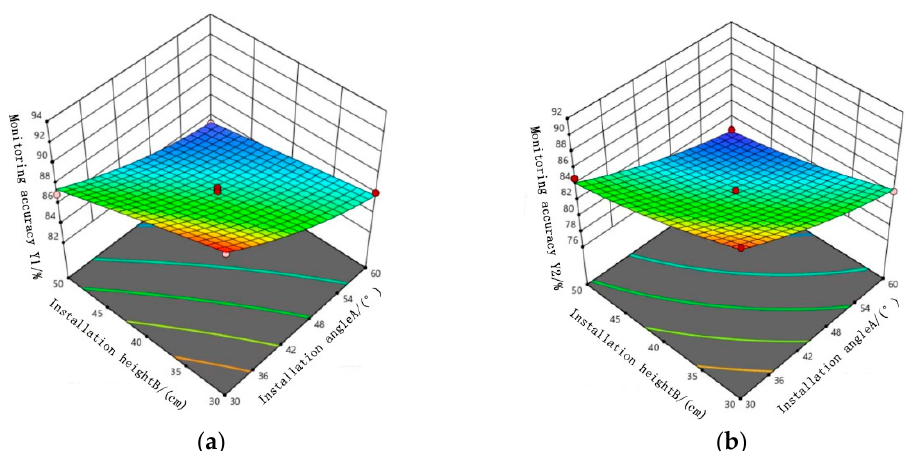
Figure 11. Response surface: ( a ) Response surface of various factors to monitoring accuracy Y 1 ; ( b ) Response surface of various factors to monitoring accuracy Y 2 . Response surface of various factors to monitoring accuracy Y 2 .